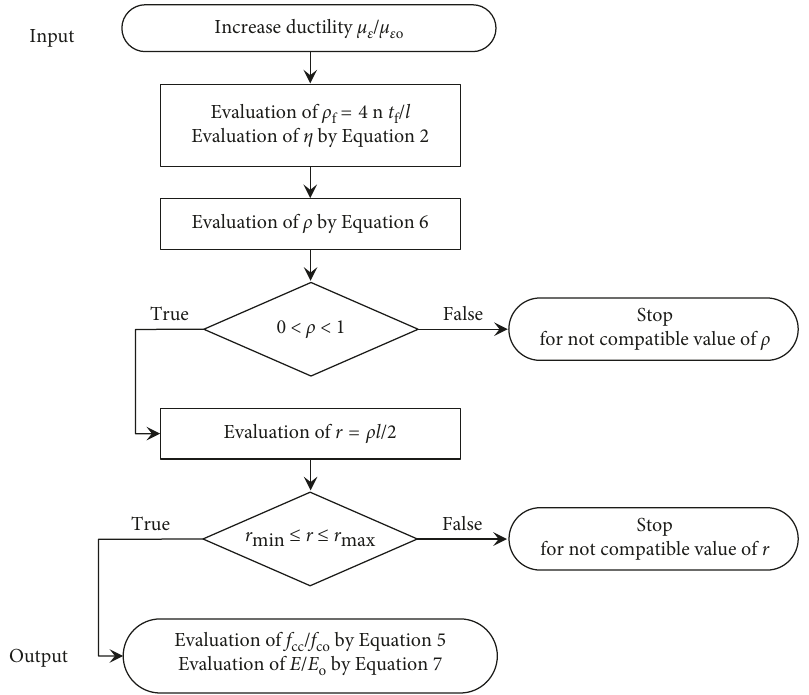
Figure 12: Flowchart for design procedure in the case of fixed increased ductility.